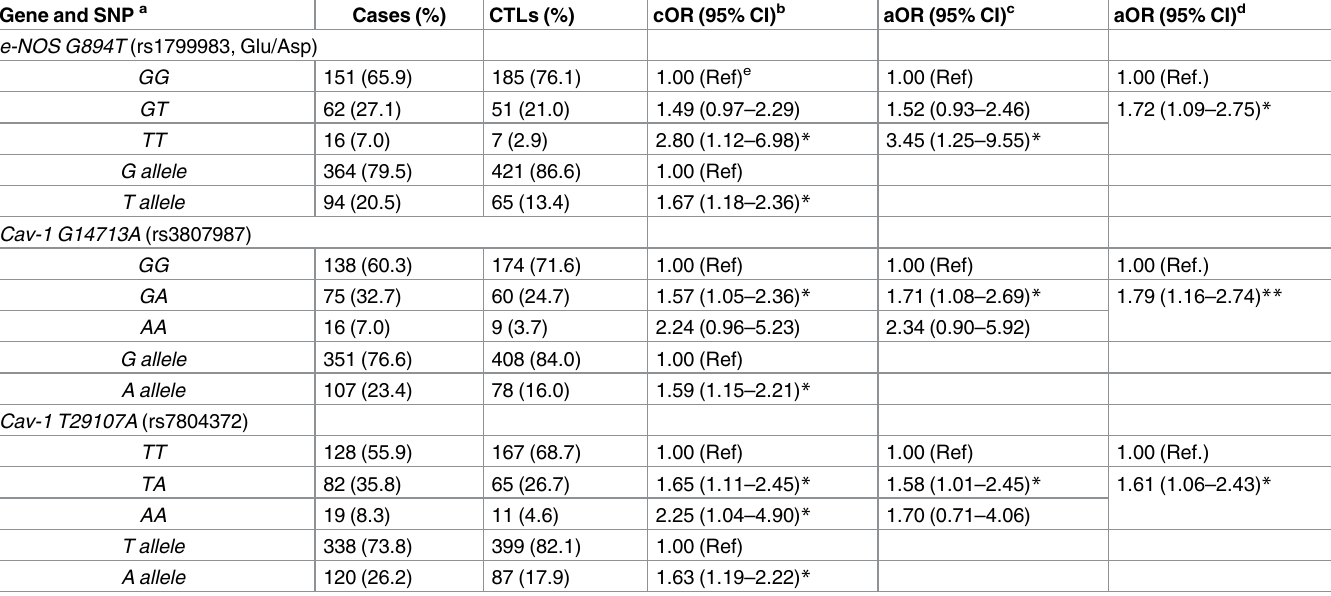
Table 2. Genetic polymorphisms of eNOS and Cav-1 genes in association with LAA stroke risk. Gene and SNP